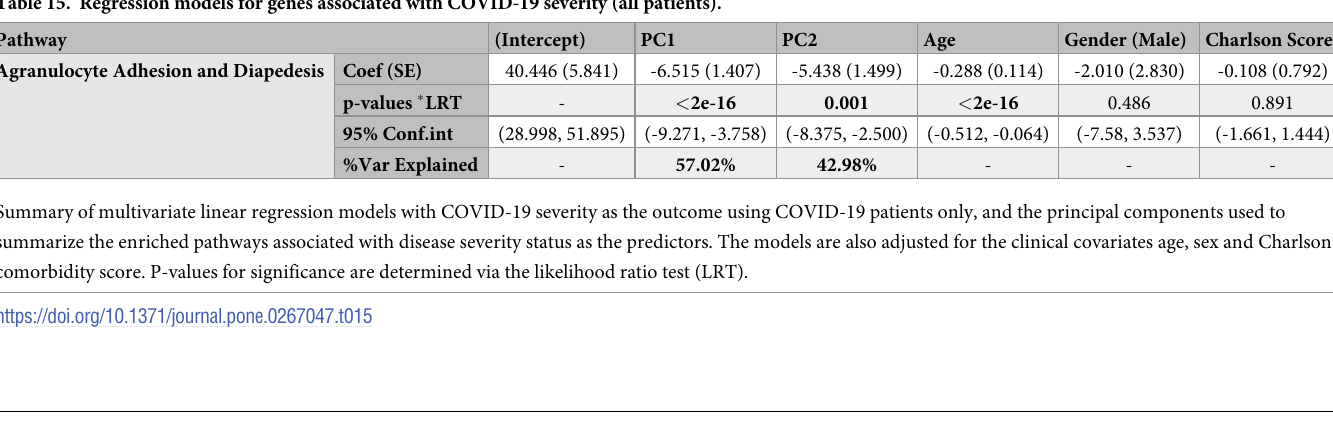
Table 15. Regression models for genes associated with COVID-19 severity (all patients). Pathway (Intercept) PC1 PC2 Age Gender (Male) Charlson Score Agranulocyte Adhesion and Diapedesis Coef (SE)